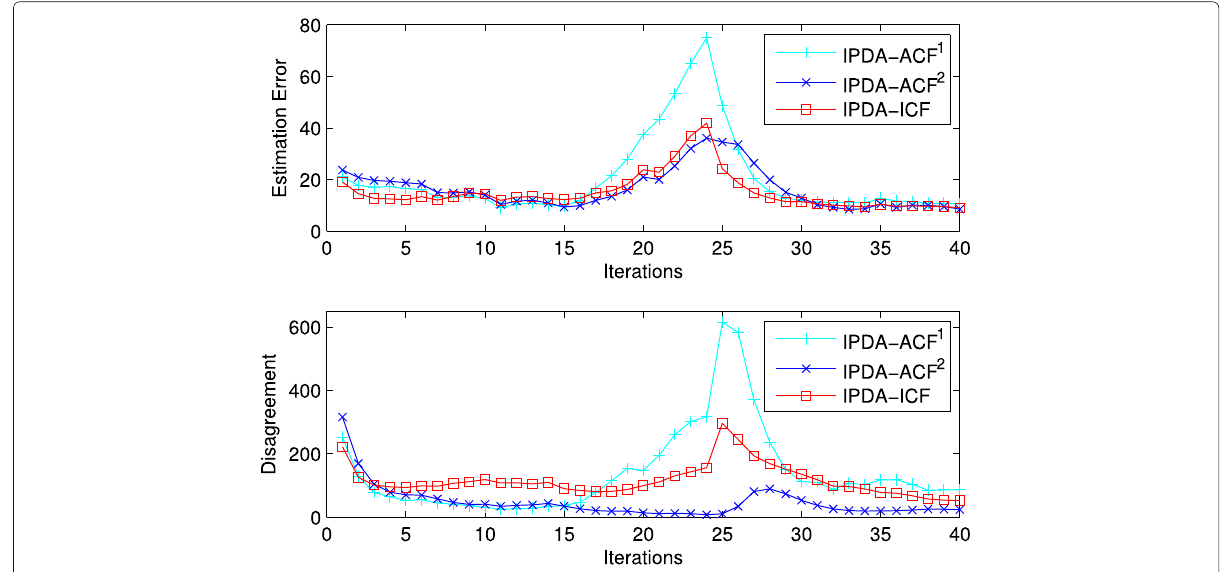
Fig. 9 Performance of the algorithms: occulted